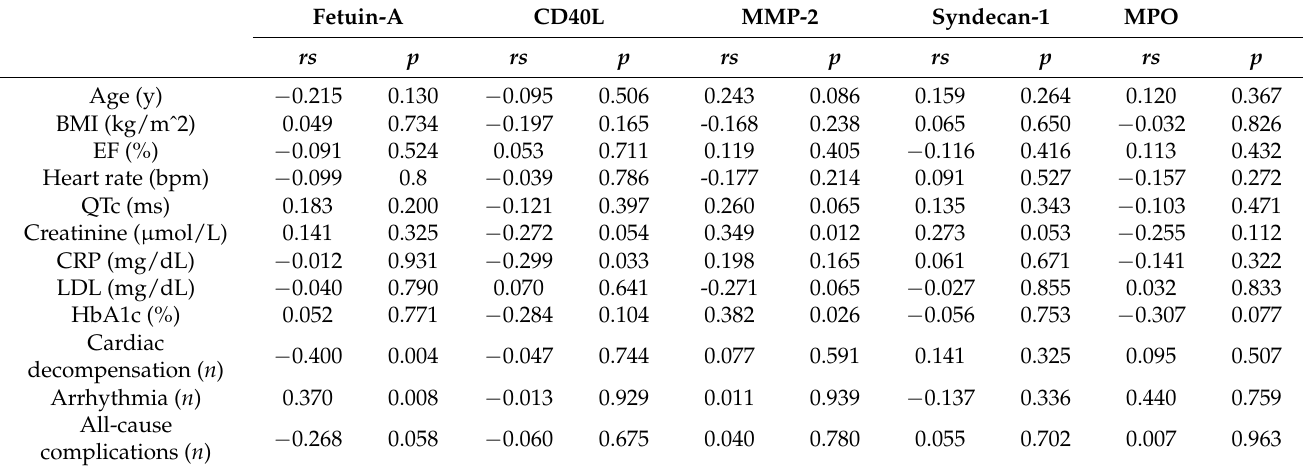
Table 2. Bivariate correlation and point-biserial correlation analysis of baseline characteristics and